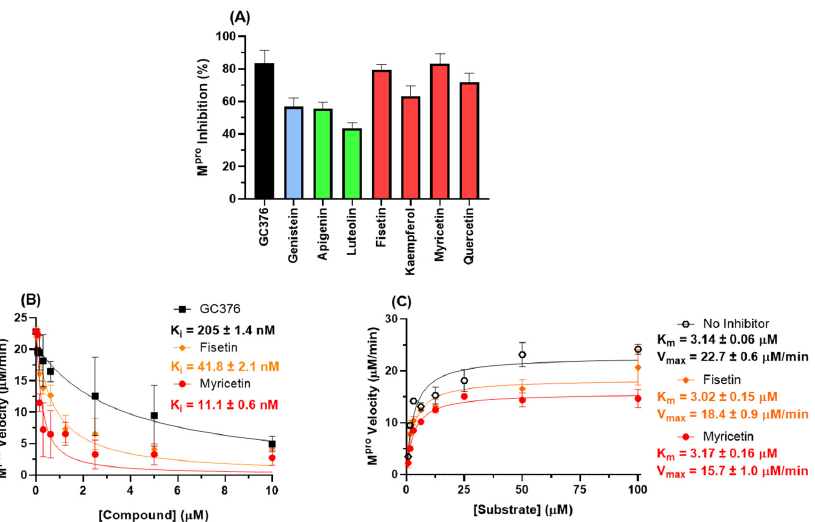
Figure 8. ( A ) Inhibition percentage of flavonoids (10 µ M) to 88.8 nM M pro . Blue, green, and red bars correspond to isoflavone, flavones, and flavonols, respectively. ( B ) The enzymatic inhibition profile for fisetin, myricetin, and GC376 (positive control) for 88.8 nM M pro in PBS. ( C ) Michaelis–Menten enzymatic mechanism for M pro in the absence and presence of a fixed fisetin or myricetin concentration (2.5 μ M) at different substrate concentrations.